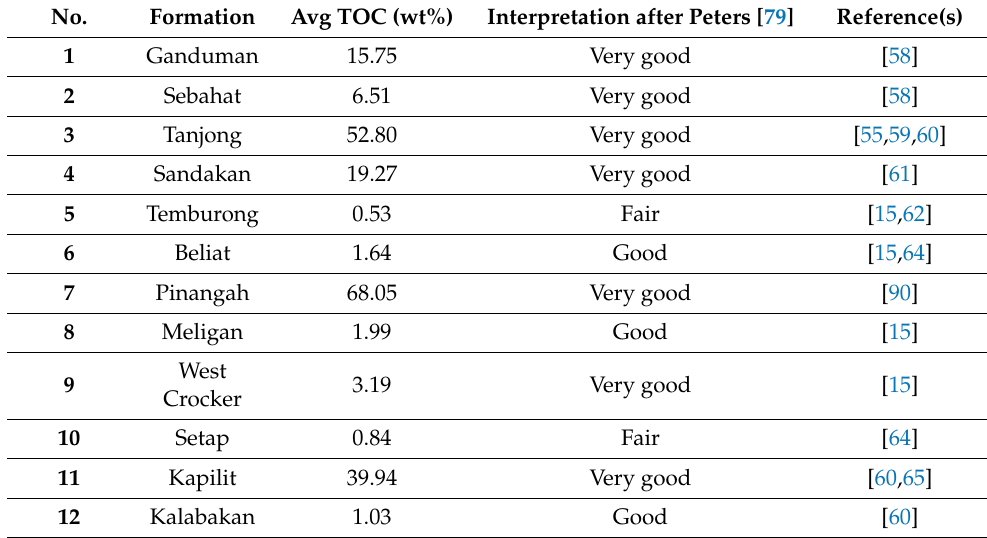
Table 8. Interpretation of average TOC values of formations in Sabah according to Peters